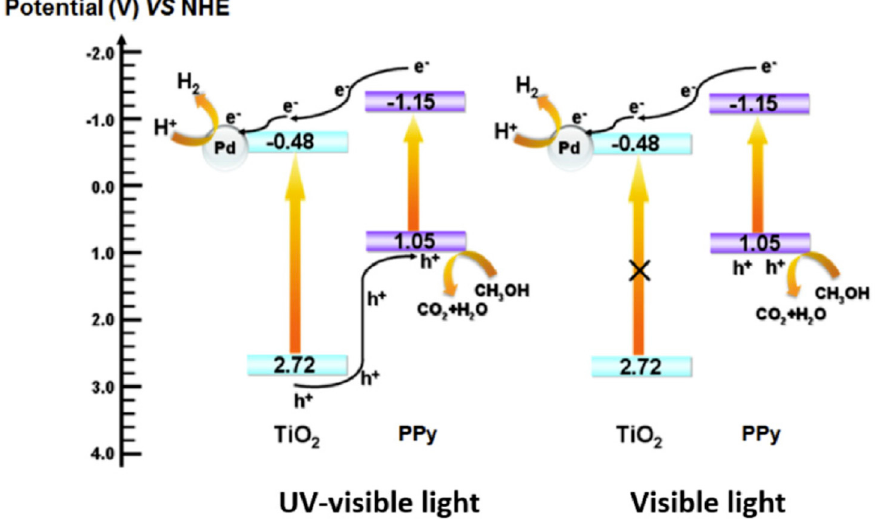
Figure 9. The energy levels diagram of TiO 2 –Pd–PPy photocatalysts and the photoexcited carrier transfer processes [67].